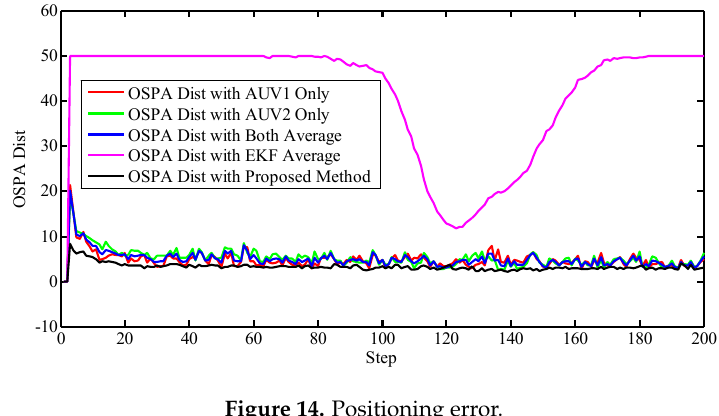
Figure 14. Positioning error.